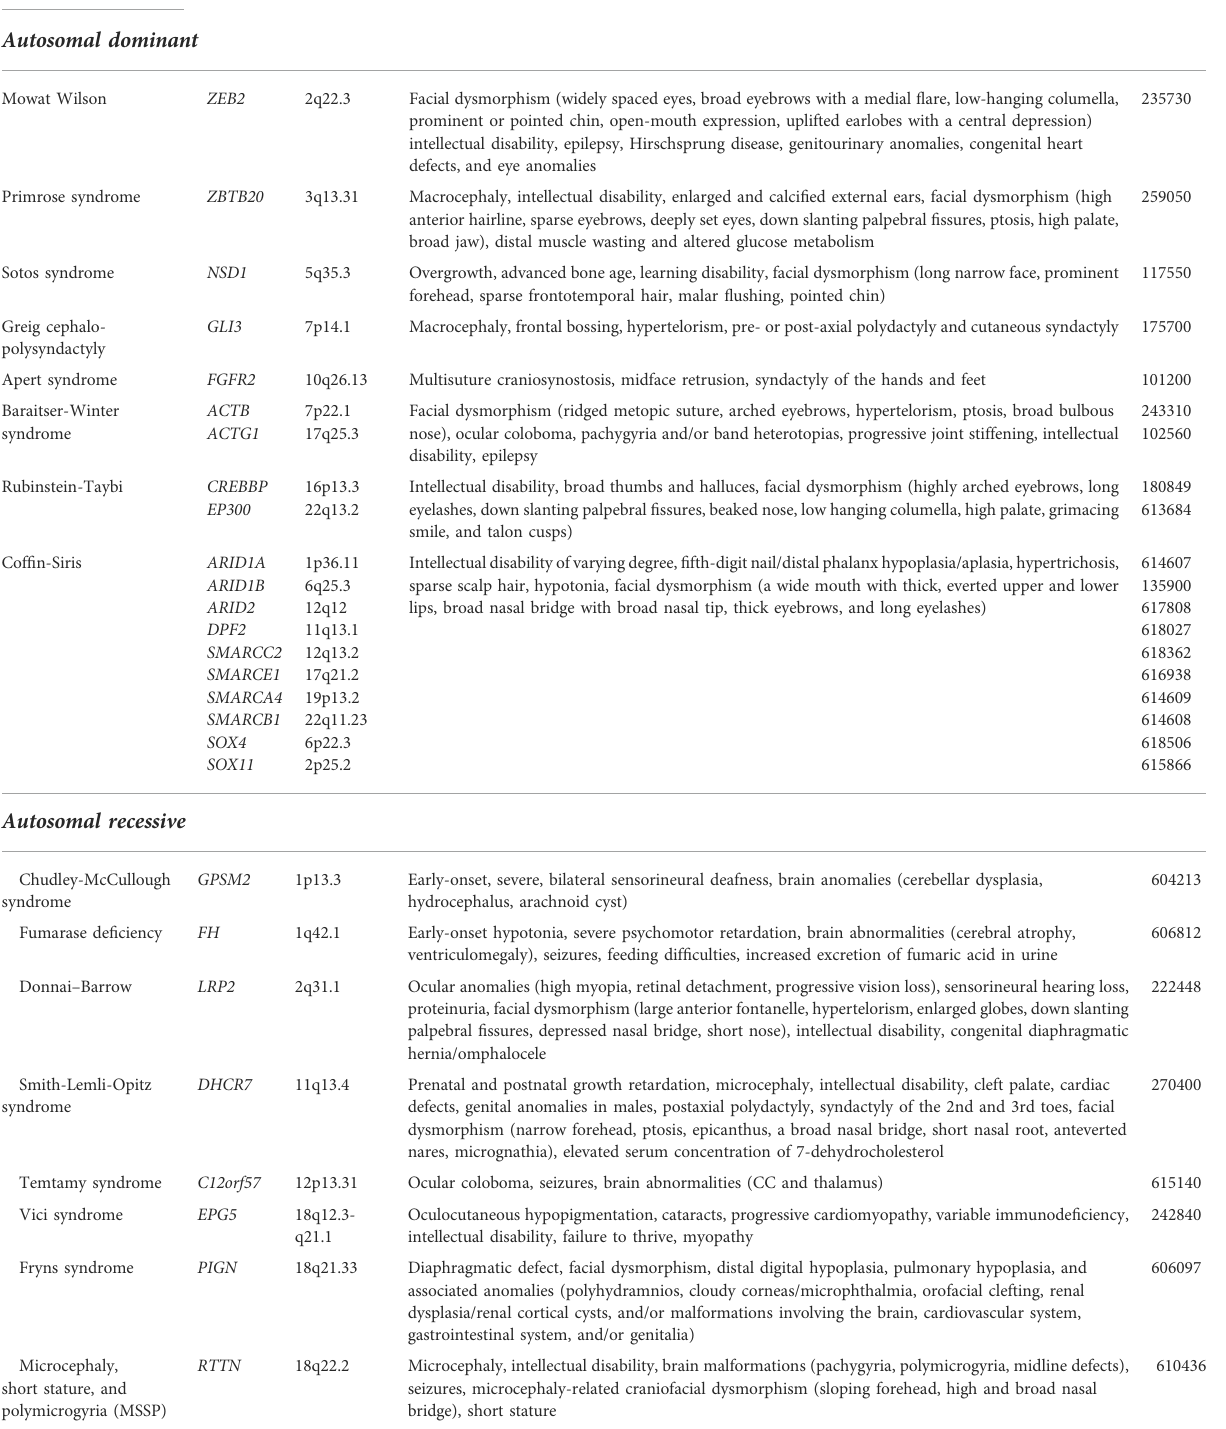
TABLE 2 Monogenic syndromes associated with ACC (Edwards et al., 2014; Hofman et al., 2020). The italic values represent